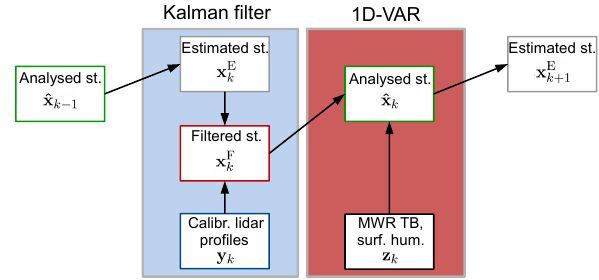
Figure 2. Sketch of the retrieval scheme. Details are given in the text. This figure is adapted from Schneebeli